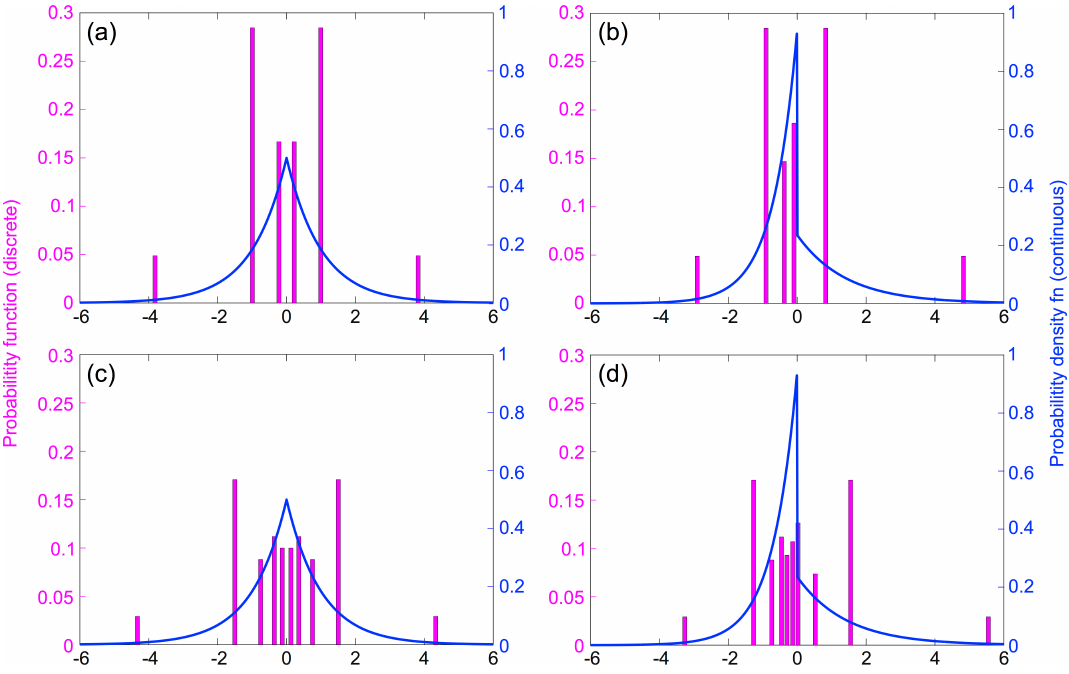
Figure 1. Comparison between the double-exponential density function and its discrete approximations for the cases: ( a ) p X = 1/2, M = 3, N = 2; ( b ) p X = 1/3, M = 3, N = 2; ( c ) p X = 1/2, M = 5, N = 2; ( d ) p X = 1/3, M = 5, N =